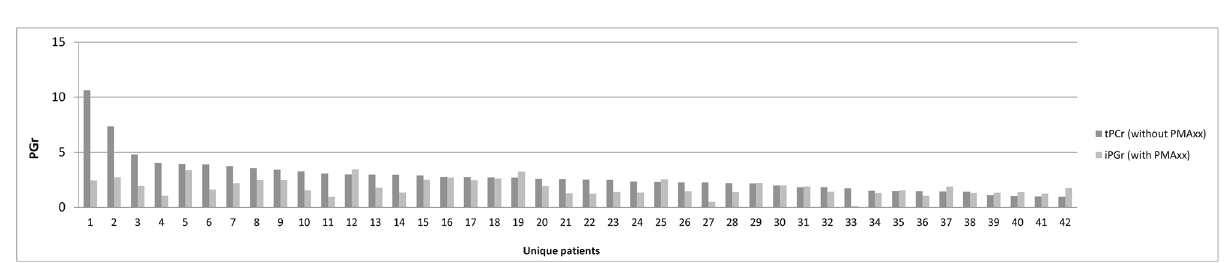
Figure 2. Frequency distribution of the tPCr in vaginal samples from patients from cohort 2. Dark grey bars show the tPCr in samples not treated with PMAxx, this includes both intra-bacterial and extra-bacterial plasmids and chromosome copies. Light grey bars show the intra-bacterial PCr in samples treated with PMAxx. PMAxx prevents the amplification of extra-bacterial plasmid and chromosomal DNA. Each number indicates a unique